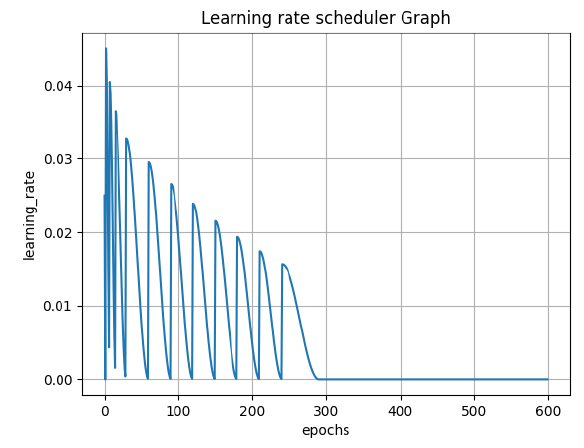
Figure 5. Learning rate